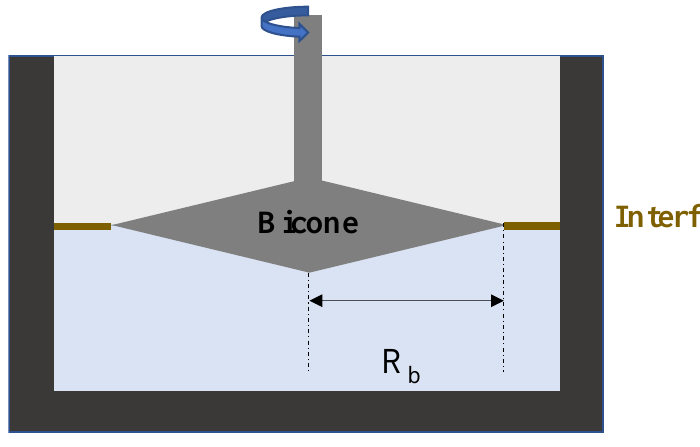
Figure 11. Profile section of the bicone device.